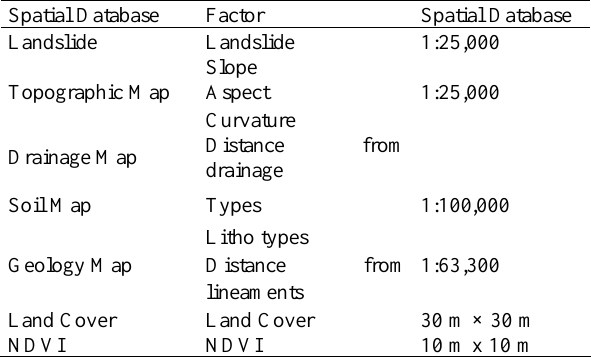
Table 1. GIS data layer of study